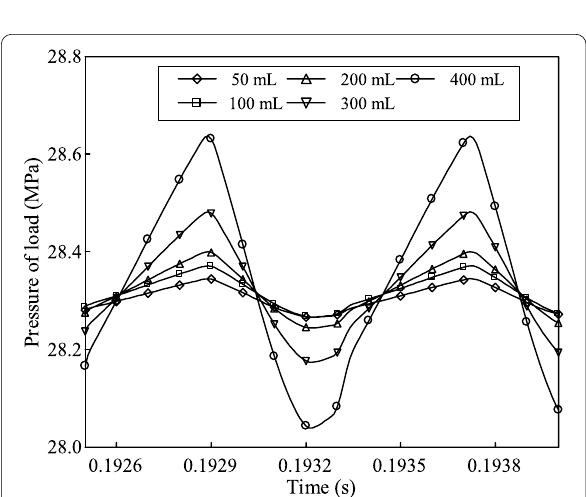
Figure 26 Pulsation characteristics of pump outlet under different volumes of